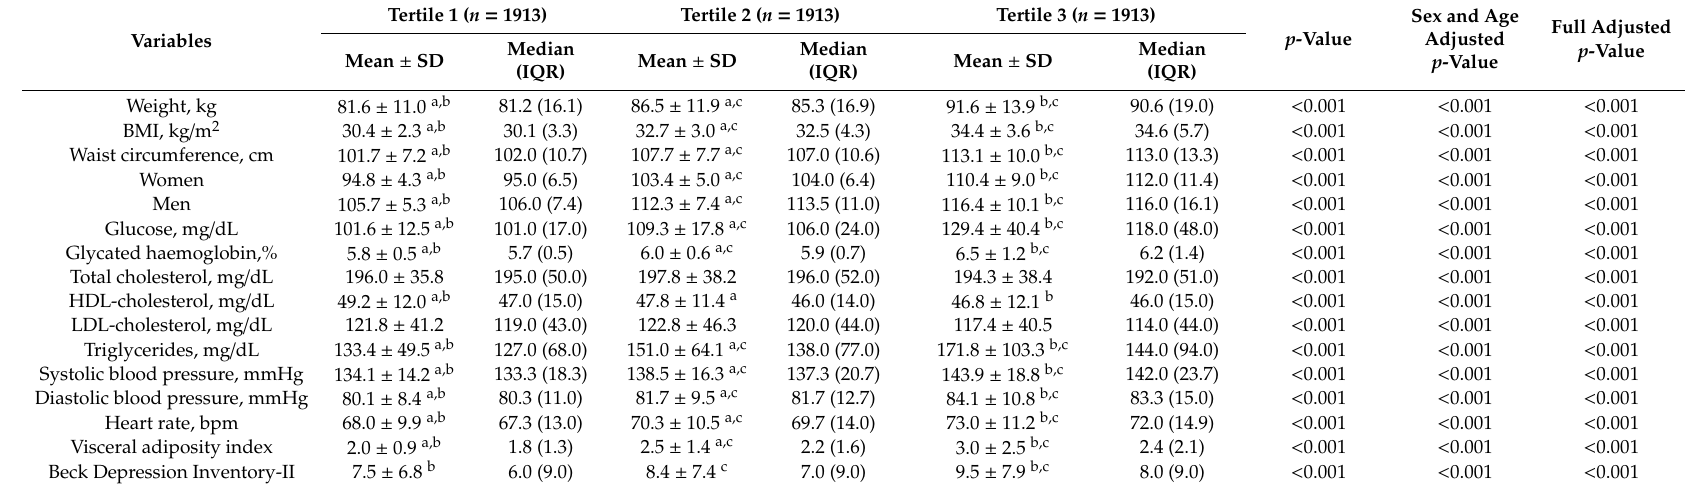
Table 2. Cardiovascular risk factors and Beck Depression Inventory-II according to tertiles of Metabolic Syndrome Severity Score (MetSSS).